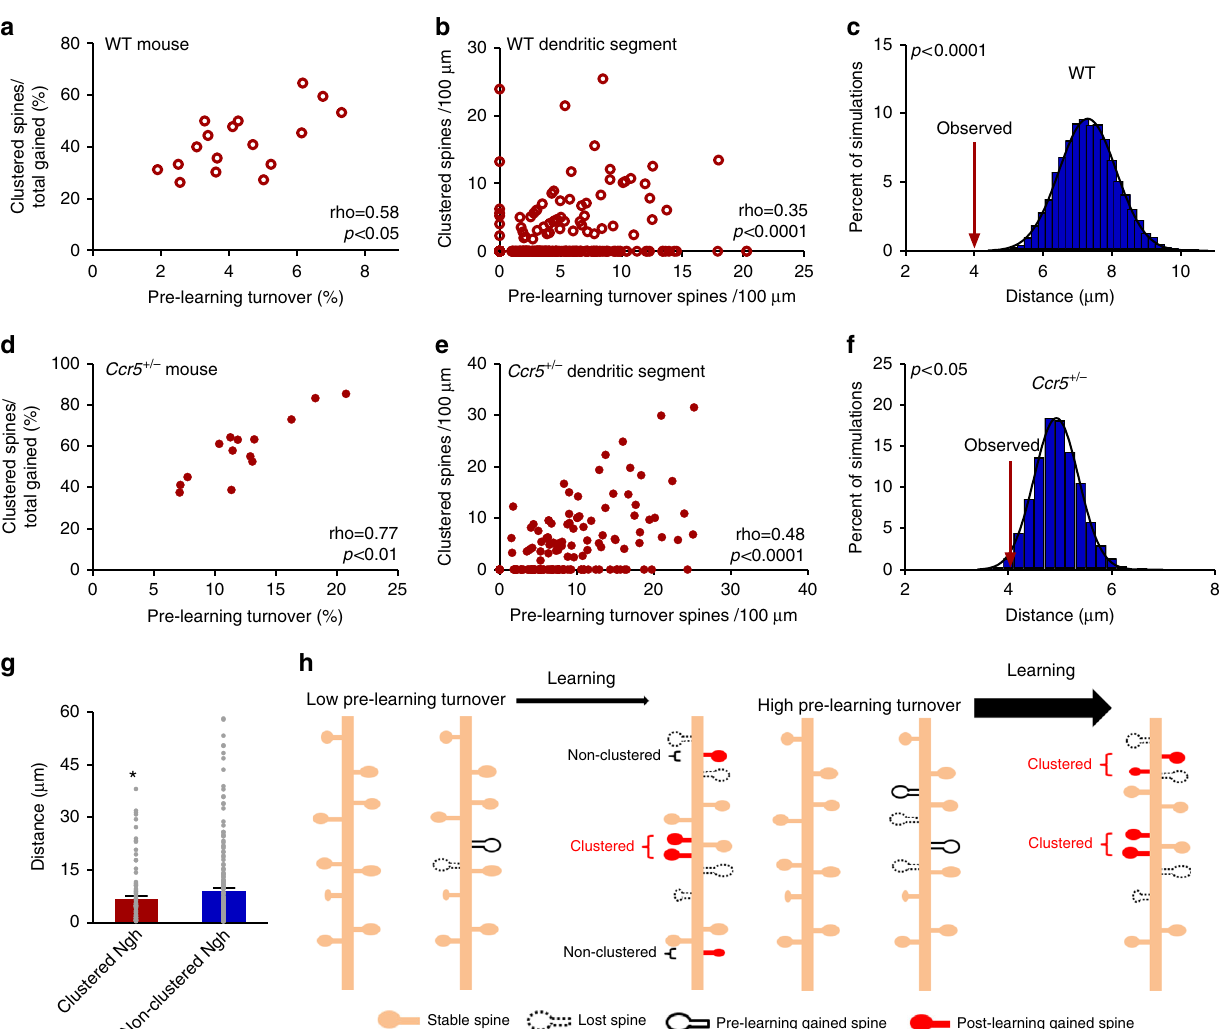
Fig. 3 Learning-related spine clustering occurs within segments of increased pre-learning spine turnover. a , d A signi fi cant positive correlation exists between pre-learning spine turnover and learning-related spine clustering within individual WT ( a , n = 17 mice; p = 0.0154) and Ccr5 + / − mice ( d , n = 14 mice; p = 0.0014). b , e A signi fi cant positive correlation exists between density of spines undergoing pre-learning turnover and density of learning-related clustered spines on each dendritic segment of WT ( b , n = 577 segments across 17 mice; p < 0.0001) and Ccr5 + / − mice ( e , n = 157 segments across 14 mice; p < 0.0001). Clustering and turnover were normalized to dendritic length to facilitate comparisons across mice. c , f The average nearest neighbor distance (NND) from each learning-related clustered spine to the closest pre-learning turnover spine is signi fi cantly smaller than chance in both WT ( c ) and Ccr5 + / − mice ( f ). 10,000 simulations of randomized pre-learning turnover spine positions were run, with NND from a clustered spine to a pre-learning turnover spine measured and averaged. Arrow represents the actual average NND (4.0 µ m in WT, and 4.2 µ m in Ccr5 + / − ) observed in the data. Black line is Gaussian fi t of data (WT: mean of Gaussian fi t = 7.3 µ m, n = 152 distance measurements over 17 mice; p < 0.0001; Ccr5 + / − : mean of Gaussian fi t = 4.9 µ m, n = 322 distance measurements over 14 mice; p = 0.0293, one sided). g Average distance between lost spines and gained spines is signi fi cantly smaller for clustered spine neighbors. NND were measured from each lost spine to the closest gained neighboring spine and this average distance is smaller if nearest gained spine is a part of a cluster (6.67 µ m vs 9.09 µ m, n = 98 clustered neighbor (ngh) measurements, n = 214 non-clustered neighbor measurements; Mann – Whitney U = 8996, p = 0.0440). h Model of clustered structural plasticity. Dendrites with higher rates of pre-learning spine turnover may allow neurons to more ef fi ciently sample the surrounding synaptic space and subsequently establish more clustered connections. Clustered spine addition within a small spatial window allows for stabilization of the encoded information. Spearman ’ s rho is indicated in a , b , d and e . * p < 0.05. Data are represented as mean ± s.e.m. in g . Mann – Whitney U -test was used in